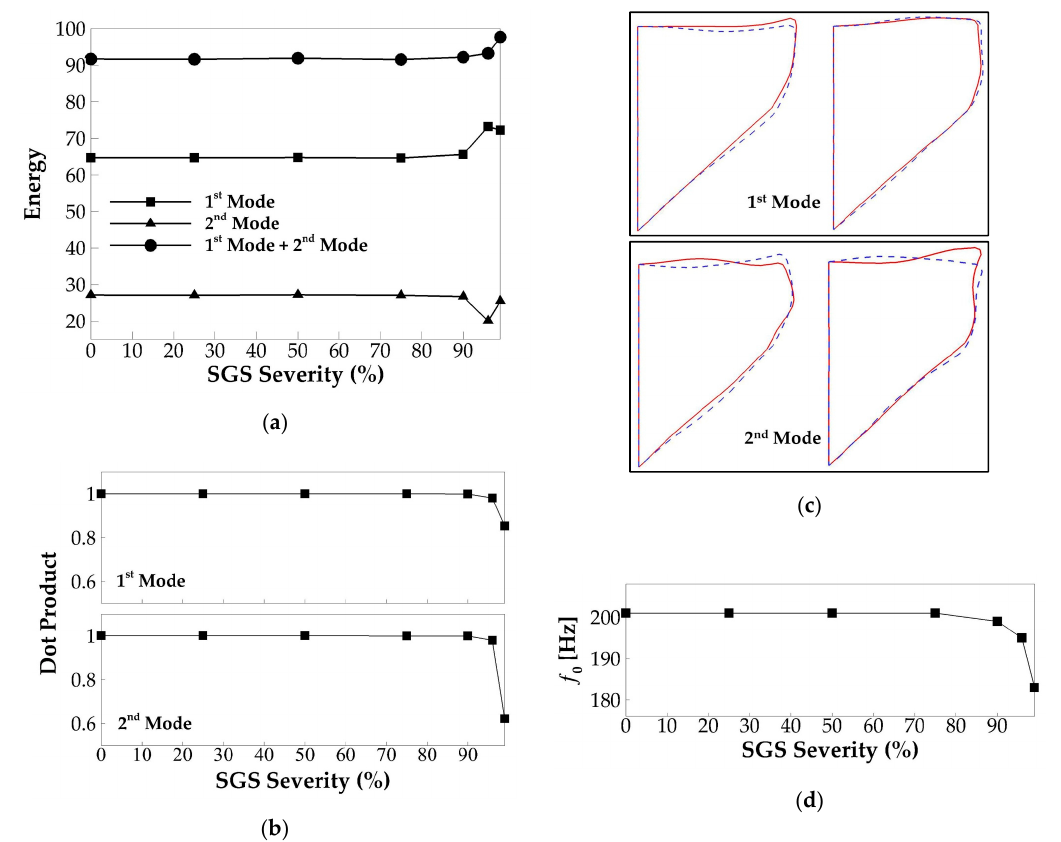
Figure 10. ( a ) The energy percentage of the two dominant proper orthogonal decomposition (POD) modes of the vocal fold vibration versus SGS severity. ( b ) The similarity of the corresponding POD modes of the vocal fold vibration versus SGS severity. ( c ) The mid-coronal profile of the vocal fold in the two dominant POD modes in the baseline case (solid lines) and the 99% SGS severity case (dashed line). The two subfigures of each mode show the two extreme phases of the mode. ( d ) The fundamental frequency of vocal fold vibration versus SGS severity.